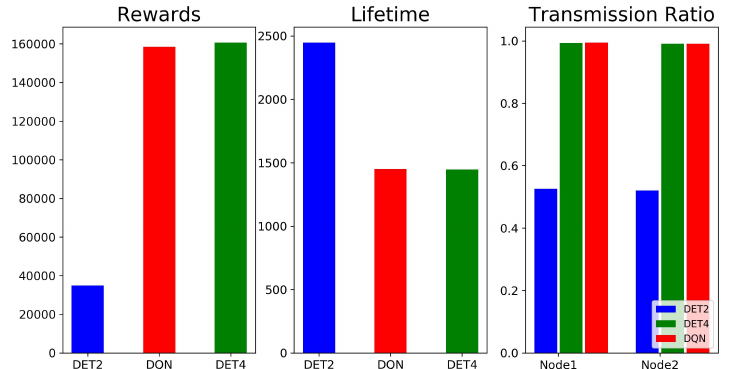
Figure 4. ( Top ) Cumulative rewards versus the number of episodes for the DQN. ( Middle ) Network lifetime versus the number of episodes for the DQN. ( Bottom ) Transmission ratios versus the number of episodes for the DQN.